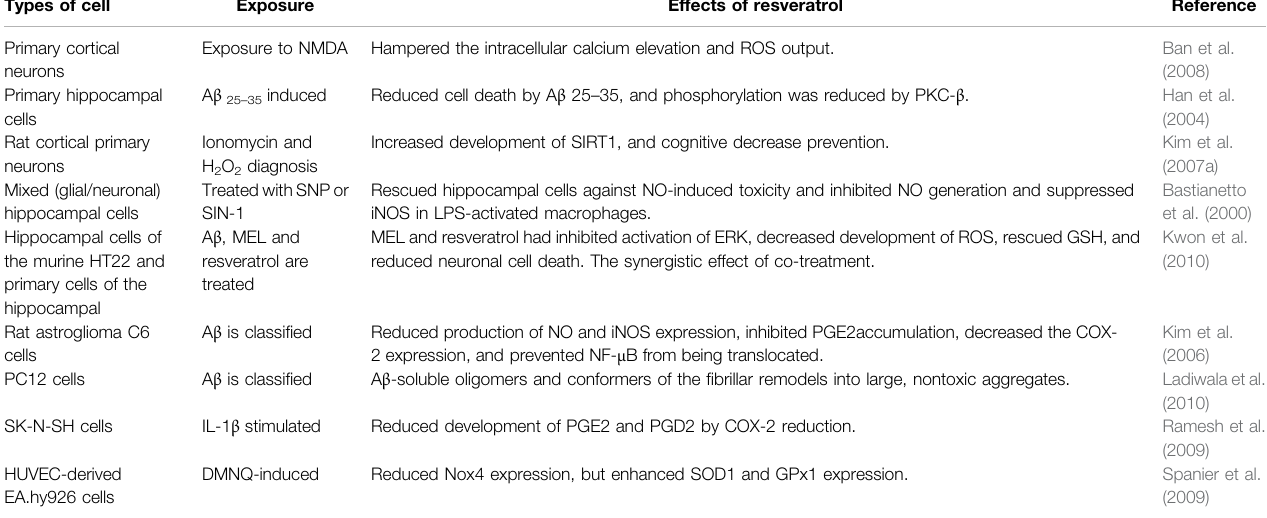
TABLE 2 | Neuroprotective effects of resveratrol in